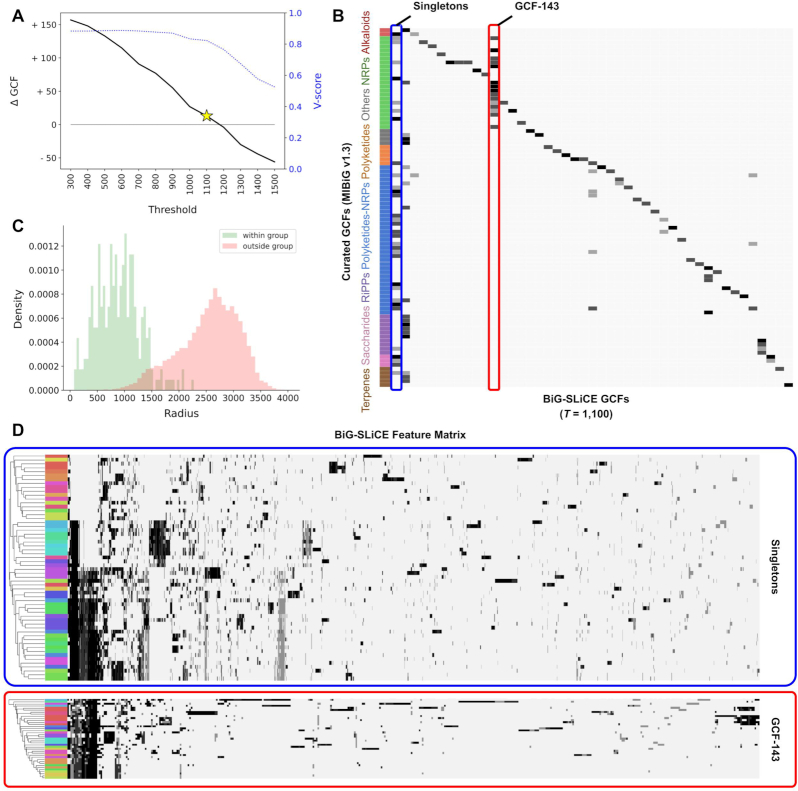

(A) BiG-SLiCE analysis results for a range of threshold values, as measured by the difference of GCF counts (ΔGCF) and the level of clustering agreement (V-score of 1.0 for perfect clustering) compared to MIBiG curated groups. A single threshold result with the lowest ΔGCF while maintaining a V-score > 0.8, T = 1,100, was used as an example for further analysis in this figure. (B) Confusion matrix of BiG-SLiCE clusters vs curated GCFs. To help in visualization, all singletons of the BiG-SLiCE result (58 GCFs) were collapsed into a single column (leftmost column, highlighted in blue box), showing together BGCs requiring a more lenient threshold (T > 1,100) to match the curated information. Conversely, another column, GCF-143 (red box), highlights the need for a stricter threshold (T < 1,100) to obtain a more fine-grained clustering for some parts of sequence space. (C) BGC-to-centroid distance value (i.e., radius) distribution of within- and between-group pairs in the curated dataset. The centroid of each curated group was calculated by averaging the feature vectors of all BGCs assigned to it. (D) Feature heat map of the collapsed singleton group and GCF-143. Colored bars on the left indicate manually curated groups. In both cases, hierarchical clustering analysis (Euclidean-based, average-linkage) shows that the underlying pattern captured by BiG-SLiCE features tends to agree with the manually curated information; i.e., rows with the same color tend to be located near each other.